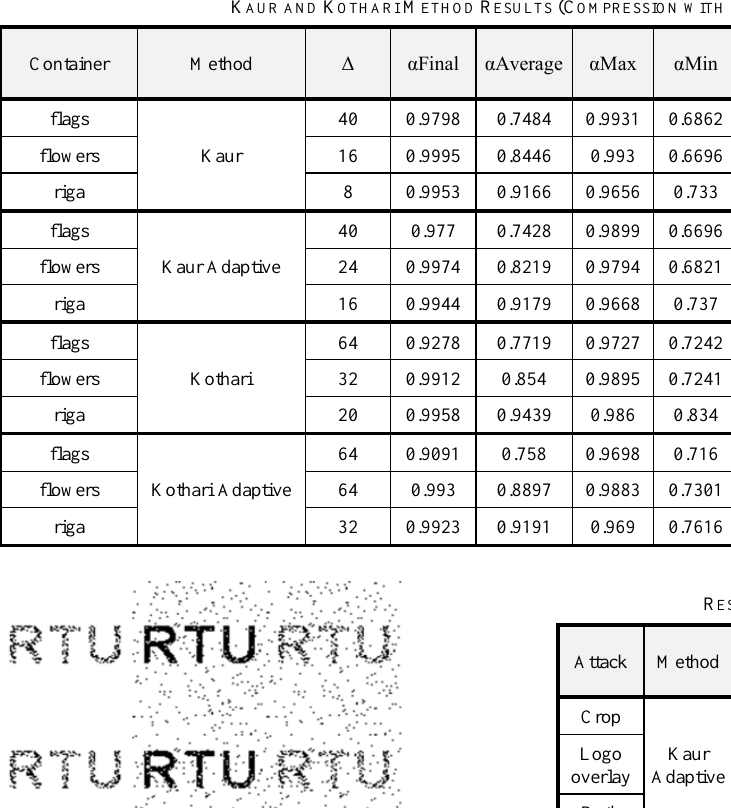
Fig. 8. Examples of watermarks extracted after geometric attacks with Kaur (top) and Kothari (bottom) methods – attacks (left to right): cropping, logo overlay, both